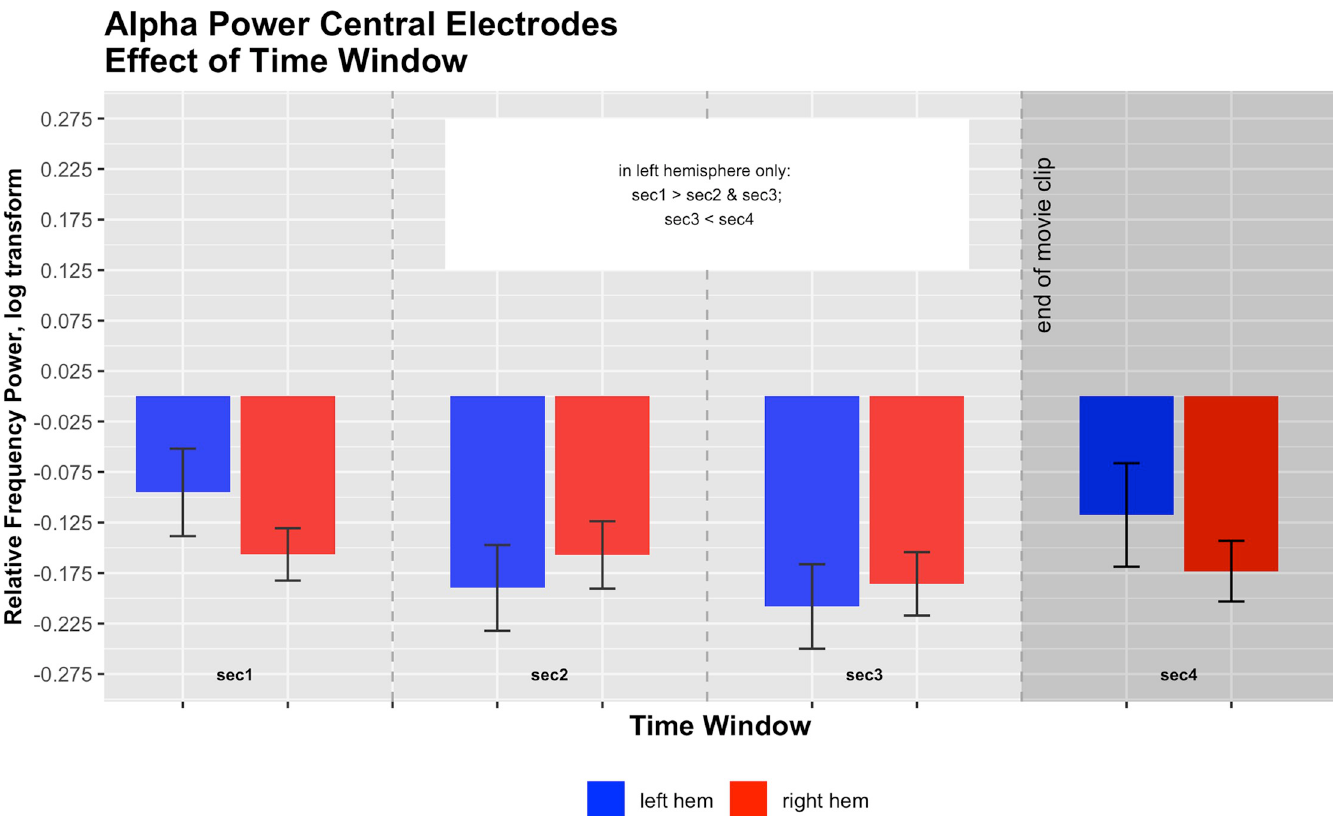
Fig 4. Central alpha frequency power (log corrected for normality) in the two hemispheres across the four time windows. Interaction effect F(2,3) = 4.21, p < 0.05, partial eta squared = 0.22.